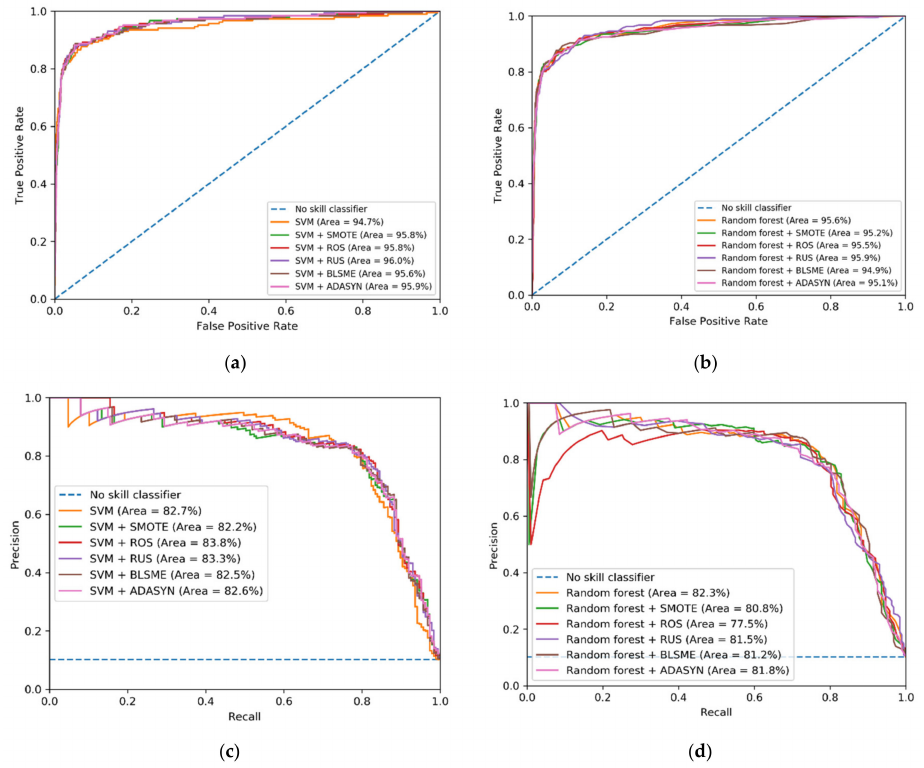
Figure A6. The ROC and PR curves of SVM and Random Forest for Fold 5; ( a ) the ROC curve of SVM; ( b ) the ROC curve of Random Forest; ( c ) the PR curve of SVM; and, ( d ) the PR curve of Random Forest.